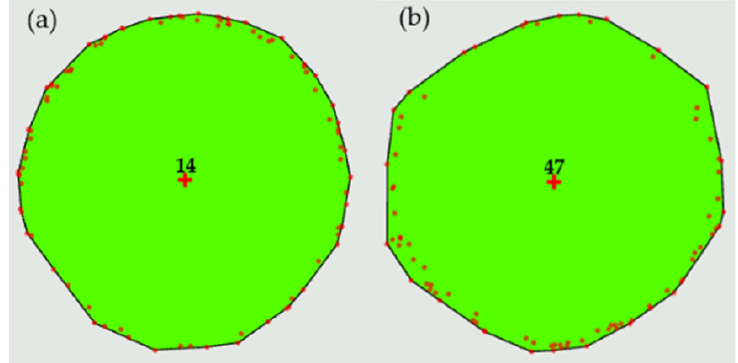
Figure 6. The deviation of stem shape profile from the regular circular shape, for a circularity of ( a ) 0.986, and ( b ) 0.974. The red points represent the TLS data, and the continuous black line represents the convex hull circumference. The numbers in the center represent the stem code ID.